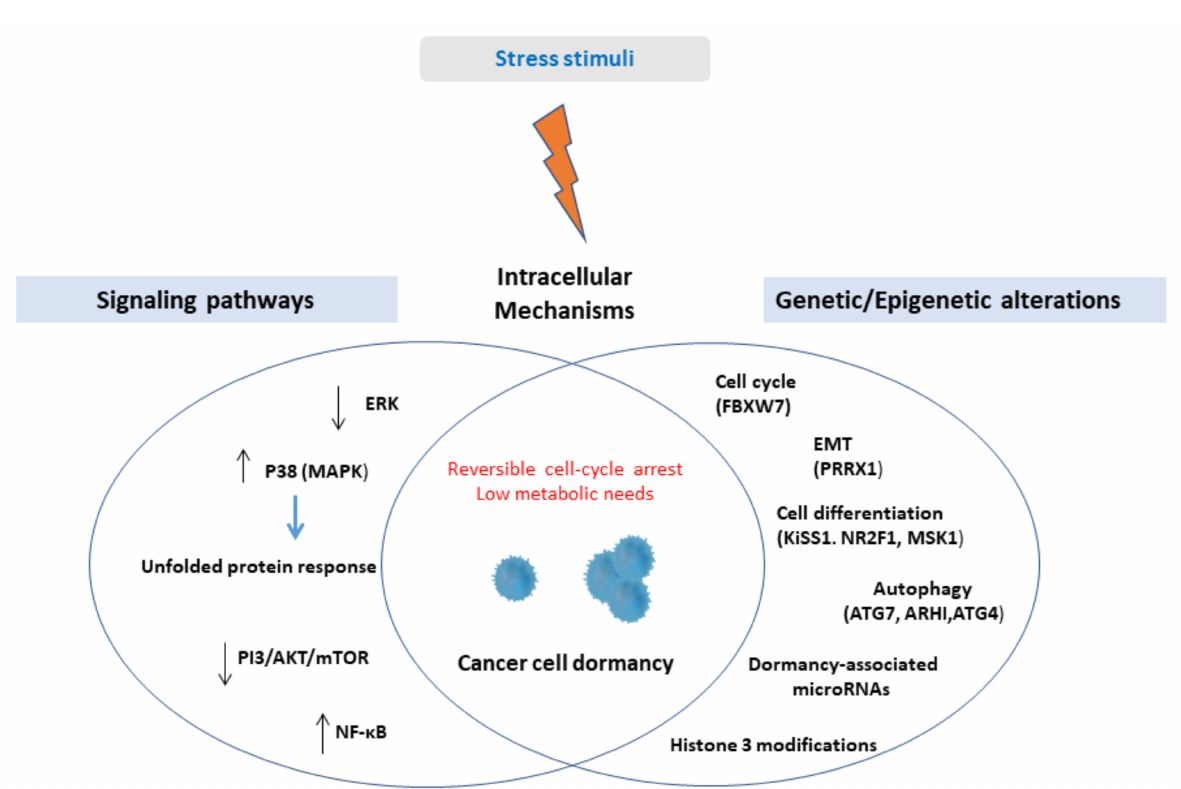
Figure 1. Upon stress stimuli, solitary cancer cells or small clusters of cells might activate cell-intrinsic mechanisms in order to enter a reversible state of non-proliferation and low bioenergetics. Cell-intrinsic mechanisms include genetic and epigenetic alterations associated with crucial cell functions, namely cell proliferation, cell differentiation, epithelial- mesenchymal transition, autophagy, and deregulation of several signaling pathways, among them, the most studied being the upregulation of p38 kinase. Abbreviations: ERK = extracellular signal-regulated kinase, MAPK = mitogen-activated protein kinase, PI3 = phosphatidylinositol 3-kinases, AKT = protein kinase B, mTOR = mammalian target of rapamycin, NF- κ B = nuclear factor kappa light chain enhancer of activated B cells, EMT = epithelial-mesenchymal transition, FBXW7 = F-box and WD repeat domain containing 7, PRRX1 = paired-related homeobox transcription factor, NR2F1 = nuclear receptor subfamily 2, group F, member 1, MSK1 = mitogen- and stress-activated protein kinase 1, ATG7 = Autophagy-related 7, ARHI = aplasia Ras homolog member